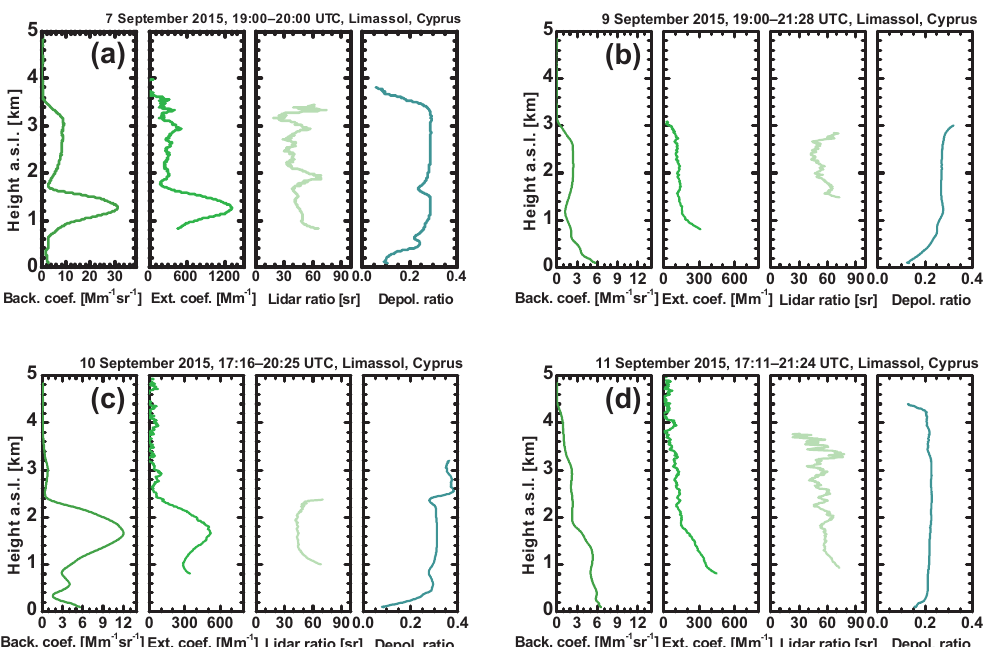
Figure 9. Mean vertical profiles of the 532nm particle backscatter coefficient, extinction coefficient, lidar ratio, and particle linear depolar- ization ratio for the observational periods, given on top of the panels, on 7–11 September 2015. The Raman lidar method is applied. Retrieval uncertainties are of the order of 10% (backscatter coefficient, depolarization ratio) and of 20% (extinction coefficient, lidar ratio) at dense dust